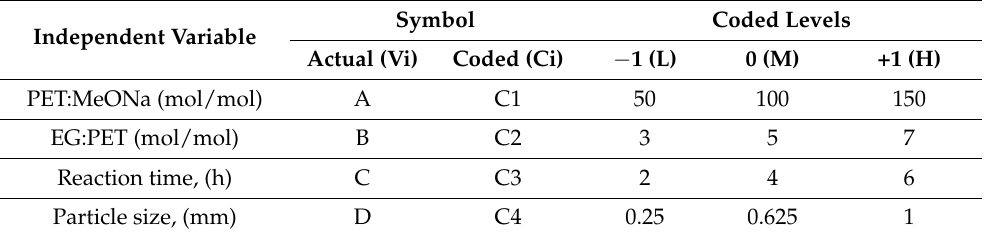
Table 1. Coded and uncoded values of independent